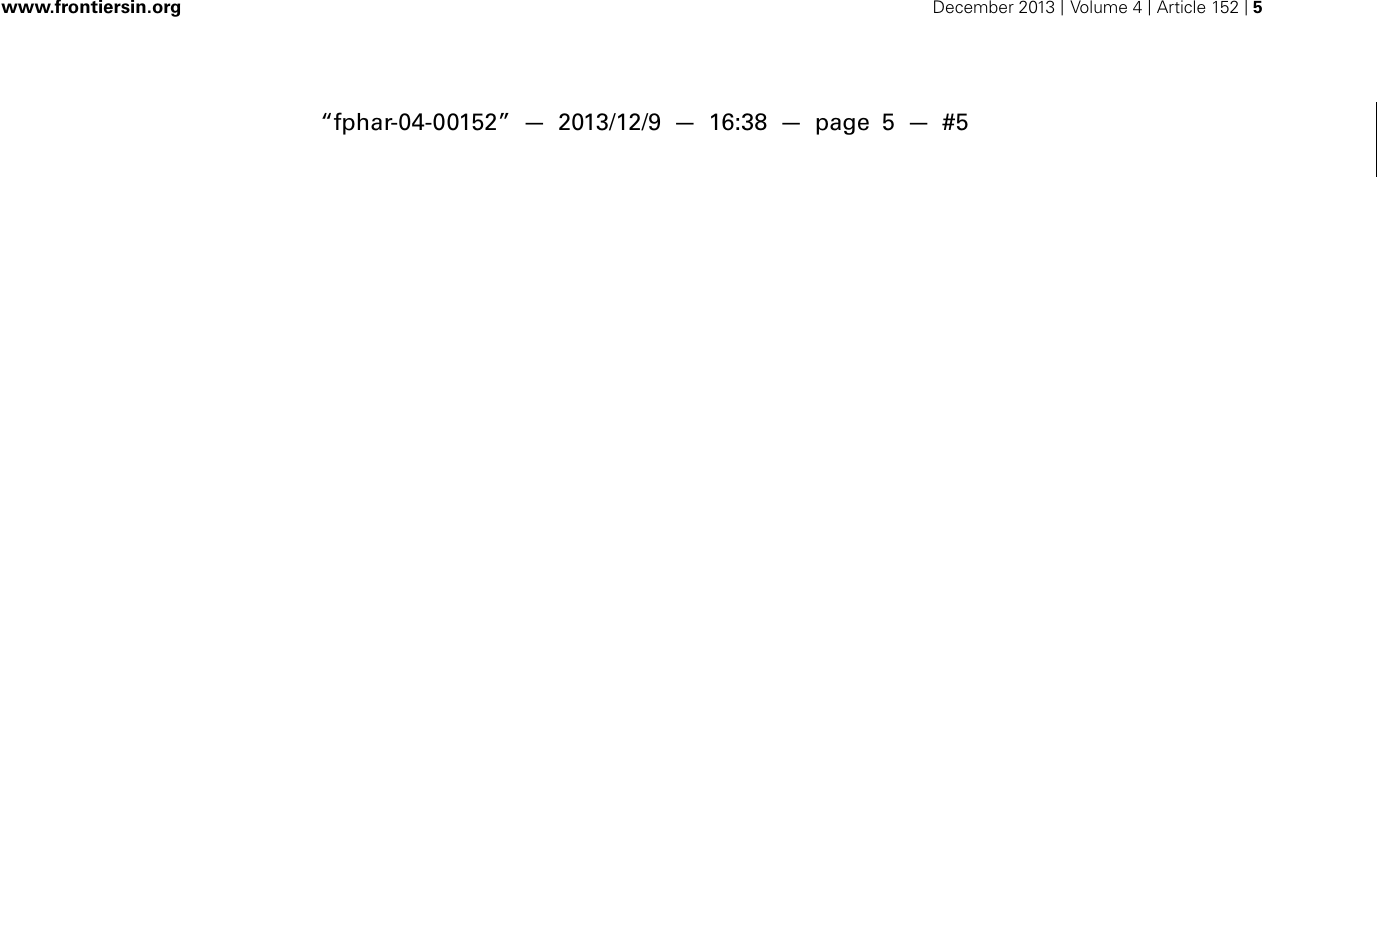
(C : 6 h and D : 12 h ) as described in Section “Materials and Methods.” Data are expressed as mean ± SEM ( n = 6). Mean values in sham-treated groups were scaled to 100%. * p < 0.05 vs. OGD + Rd-treated